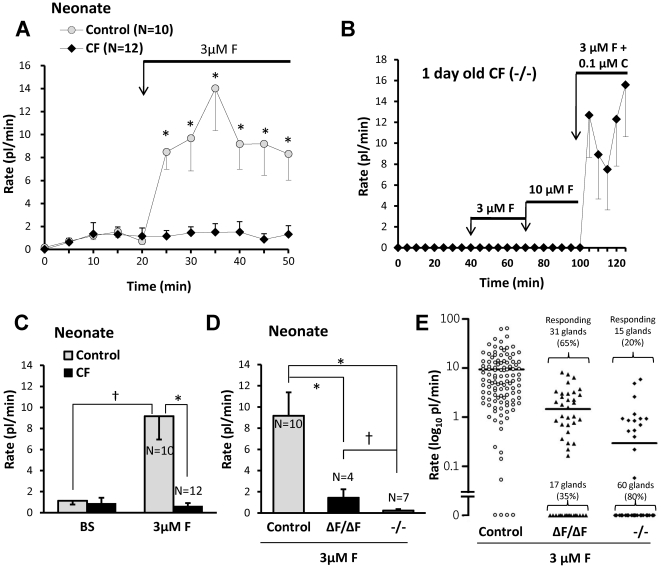
Defective forskolin-stimulated fluid secretion from CF piglet nasal glands.
A, Plots of averaged nasal gland secretion rates from 8 control and 9 CF piglets stimulated with 3 µM forskolin. The response for each piglet was the average of from 8 to 17 glands. Significantly more fluid was secreted at the first 5 min time point and at each subsequent point (t-test, * indicates P<0.05). B, Response to small carbachol stimulus proves CF nasal glands are viable. Average secretion rates of 9 nasal glands from a 1 day old CF (-/-) piglet as a function of time and stimulation with forskolin (3 and 10 µM) and carbachol (0.1 µM). C, Summary data for 10 control and 12 CF piglets (* indicates t-test P<0.003, † indicates paired t-test P<0.006). Rates were averaged over the entire 30 min period of stimulation and the basal rate was subtracted from the forskolin-stimulated rates. If rates are determined for only the last 20 min of stimulation (sustained rates) the rate is ∼10% higher for forskolin and ∼20% less for carbachol. The response of CF glands to 3 µM forskolin did not differ significantly from zero. D, Mean response rates to 3 µM forskolin plotted separately for each genotype. (* indicates t-test P<0.006, † indicates Mann-Whitney test P<0.03). E, Response rates for all glands tested, plotted separately for genotype; horizontal bars indicate means.